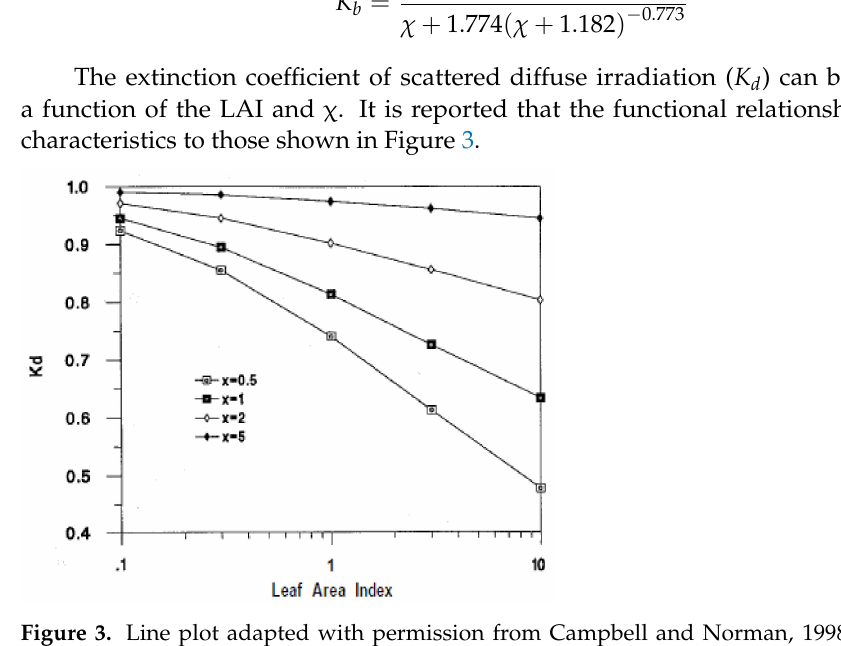
Figure 3. Line plot adapted with permission from Campbell and Norman, 1998. It depicts the extinction characteristics of diffuse irradiation in the canopy, differing in the leaf angle